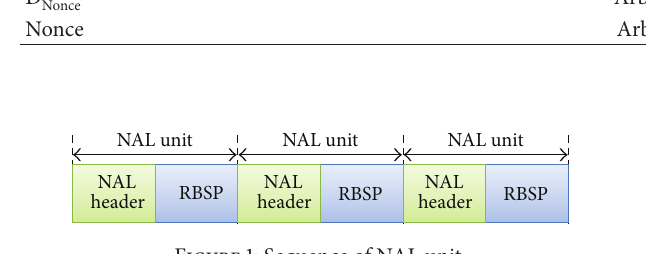
Figure 1: Sequence of NAL unit.